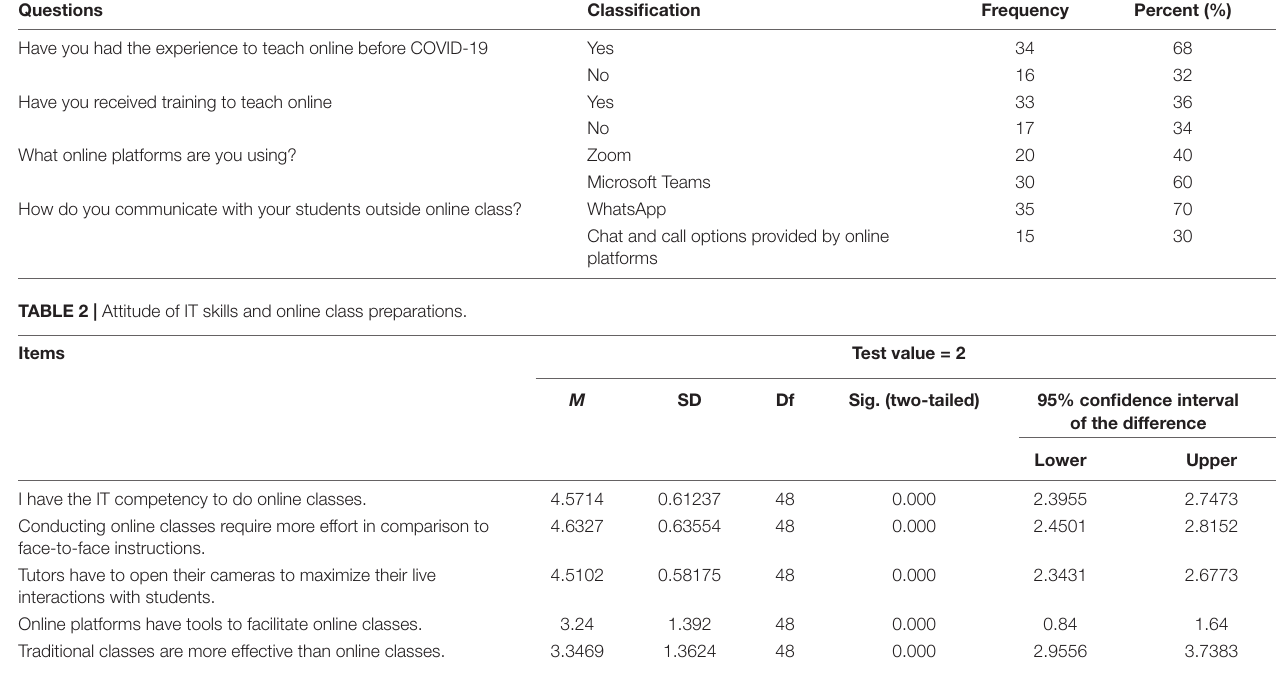
TABLE 1 | Common online platforms and teaching experiences.